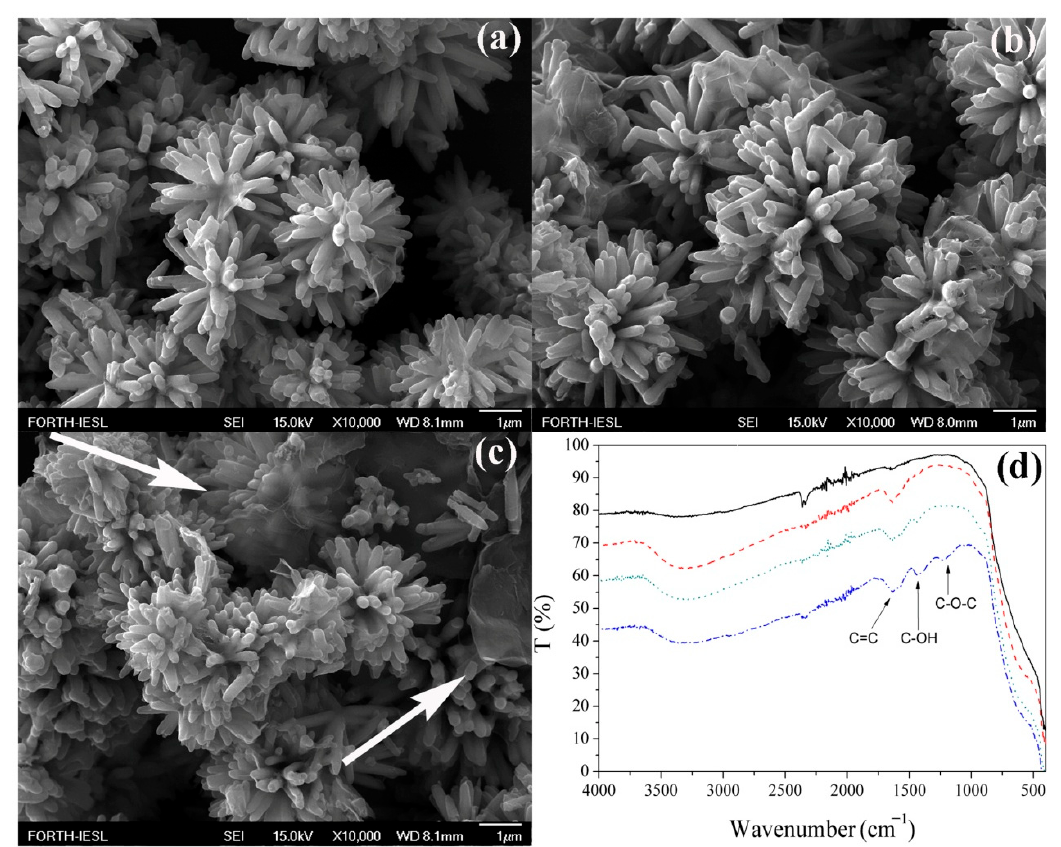
Figure 4. SEM images of ZT-rGO with ( a ) 0.5, ( b ) 2, and ( c ) 5 wt % rGO content; ( d ) ATR-FTIR spectra of the parent ZnO-TiO 2 core-shell flowers (black line, solid) and ZT-rGO at 0.5 (red line, dash), 2 green line, dot), and 5 wt % (blue line, dash dot) rGO loading. The white arrows indicate unattached rGO sheets.